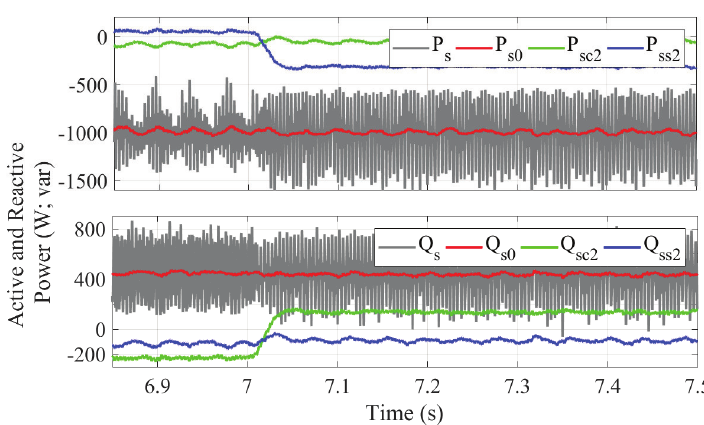
Figure 13. Stator active (W) and reactive (var) power at the beginning of the activation of Objective IV for experimental